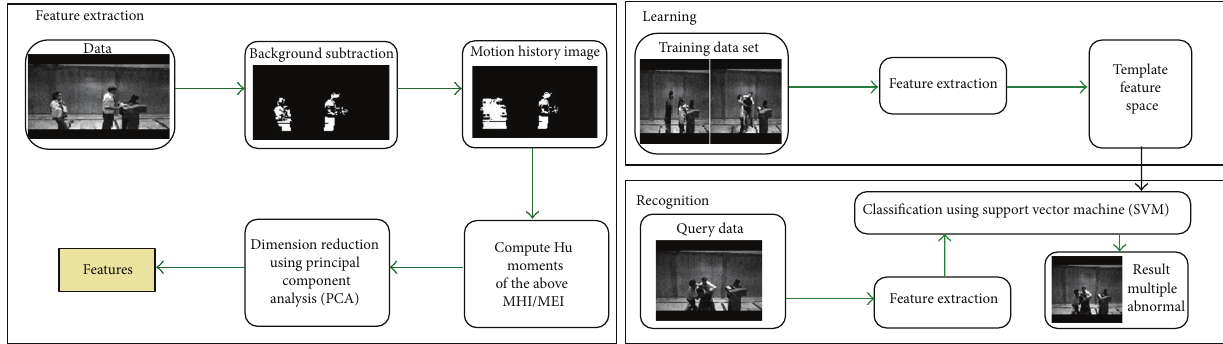
Figure 2: Functional architecture for the proposed system.